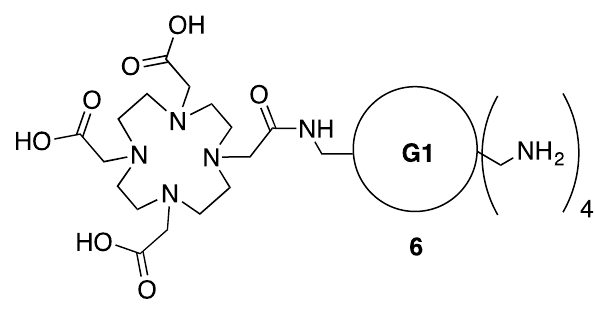
Figure 8. Intermediate 6 . Figure 10. Intermediate 6 .